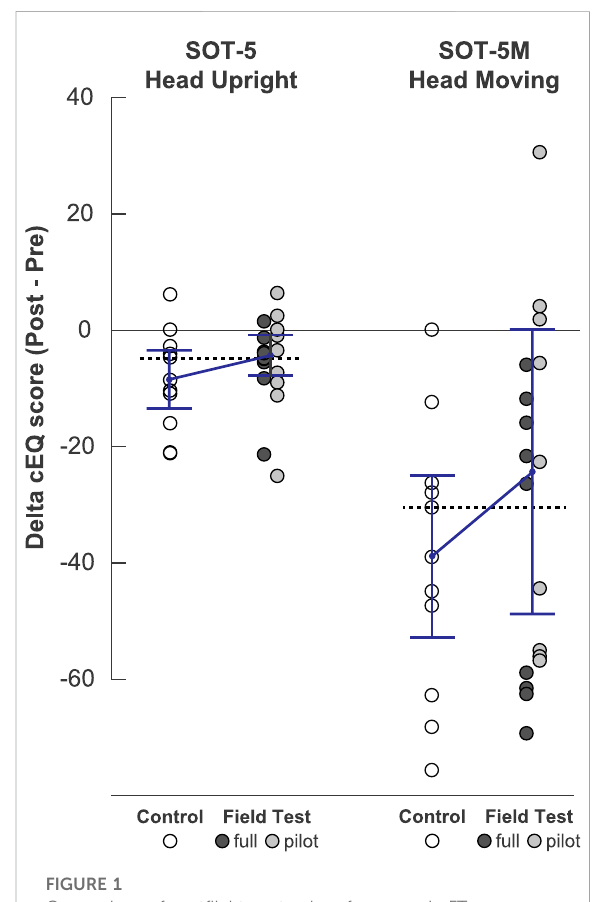
FIGURE 1 Comparison of post fl ight postural performance in FT participants and controls. The left panel is the SOT 5 condition (eyes closed, sway-reference support, with head upright). The right panel is the SOT-5M condition (eyes closed, sway- referenced support, with pitch head movements). Individual data points represent the difference between pre- and post- fl ight Equilibrium scores, with medians ± IQR for each group overlaid. For reference, the dashed line represents the grand median for all